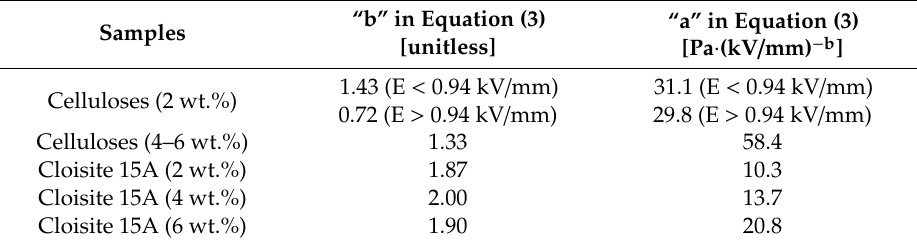
Table 2. Fitting parameters of Equation (3) for the di ff erent 2 to 6 wt.% dispersions in castor